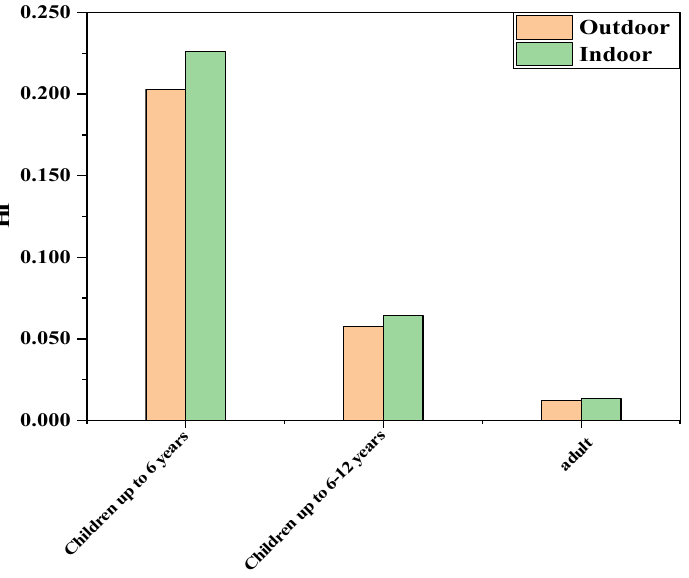
Figure 6. The hazard index (HI) average values of outdoor and indoor dust samples in school envi- ronment. Table 5. Relationship between the characteristics of dust pollution and the human health risks.